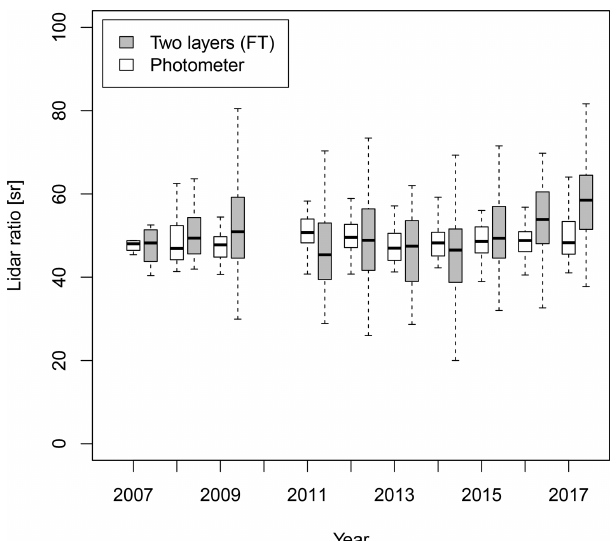
Figure 11. Upper layer lidar ratio from two-layer method (gray boxes) and from Aeronet inversion of the sun photometer data at Izaña Observatory (white boxes), for each year between 2007 and 2017. The central rectangles extend from the first quartile to the third quartile and the median is represented by a horizontal line. The whiskers are defined as the upper and lower quartiles ± 1.5IQR (interquartile range).